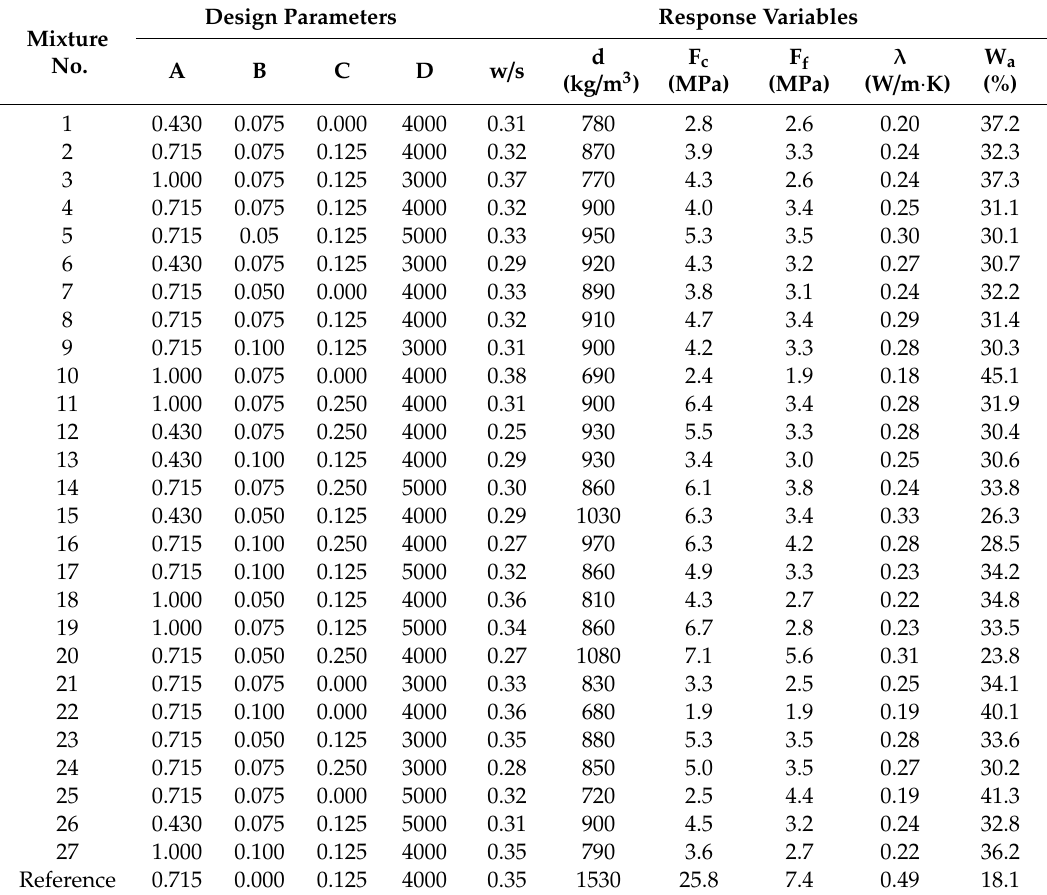
Table 3. Box–Behnken factorial design and test